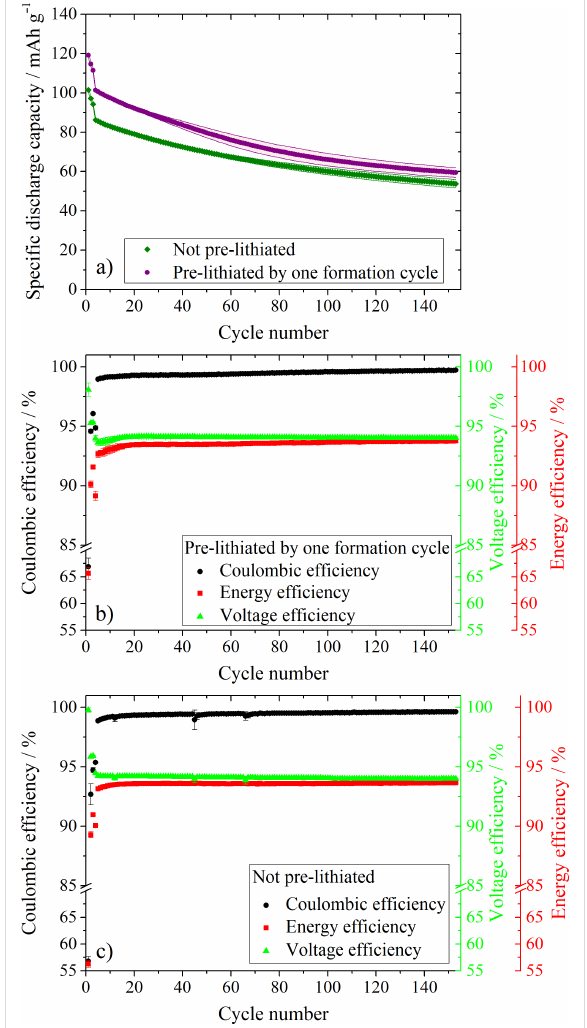
Figure 6: Constant current cycling of prelithiated (a, b) and non- prelithiated (a, c) C:Si 90:10 negative electrodes vs NMC-111 positive electrodes at a charge/discharge current of 100 mA g − 1 after three for- mation cycles at 10 mA g − 1 . RE: metallic lithium, cut-off voltages: 3.0 V and 4.3 V; In b) and c) the VE and EE of the prelithiated (b) and non- prelithiated (c) full cells are presented.